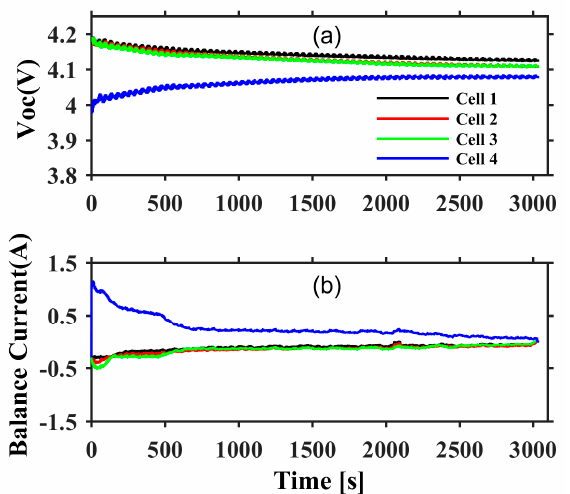
Figure 17. Experimental results for the NCA battery pack with PI controller. ( a ) OCV for each cell; ( b ) Average balancing current for each cell.